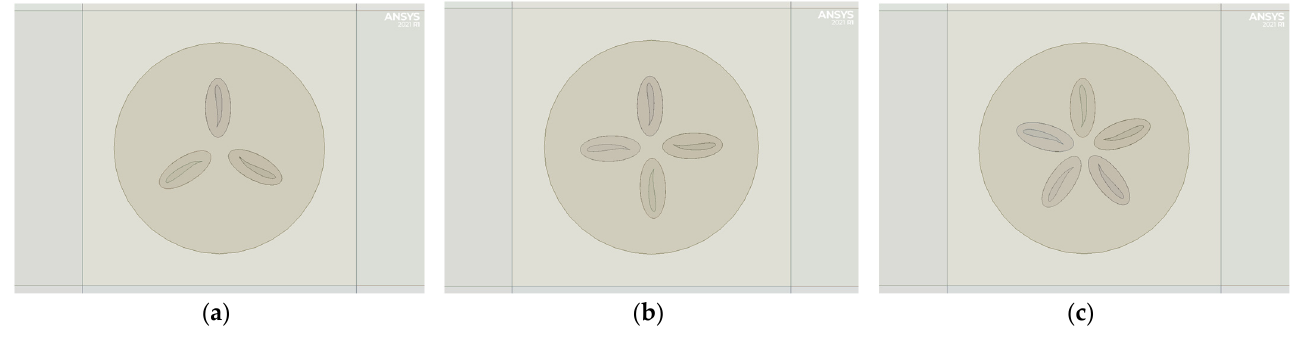
Figure 3. Close-up of Savonius turbine with: ( a ) 3 blades; ( b ) 4 blades; ( c ) 5 blades. Based on the mesh convergence for the single blade (Section 5.1), it was determined that a mesh of one million or more elements is suitable. The mesh used the same techniques as the single blade, with additional techniques of face sizing and automatic method used for complex geometry near the blades. The mesh contains roughly 1.4 million elements (Figure 4), going up to 2.3 million elements for the five-blade Savonius turbine. The orthogonal quality of the meshes was kept below 0.01 to avoid floating point errors in the simulations.